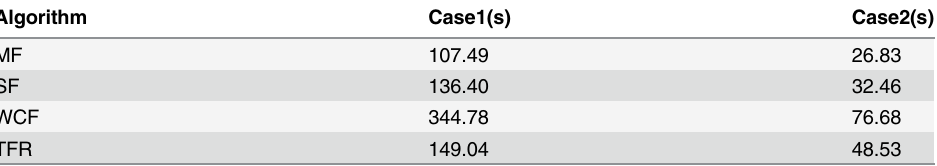
Table 4. Comparisons of fusion time among MF, SF, WCF and TFR of 30